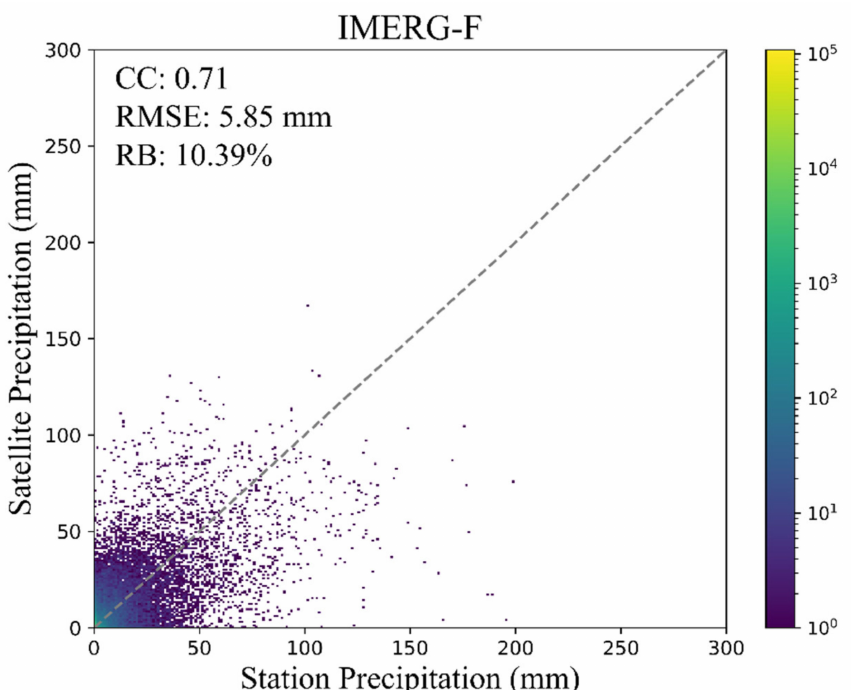
Figure 2. Density scatterplots of IMERG products versus 24 gauge observations at a daily scale. Correlation coefficient (CC), root mean square error (RMSE), and relative bias (RB) are measures of the accuracy of IMERG precipitation